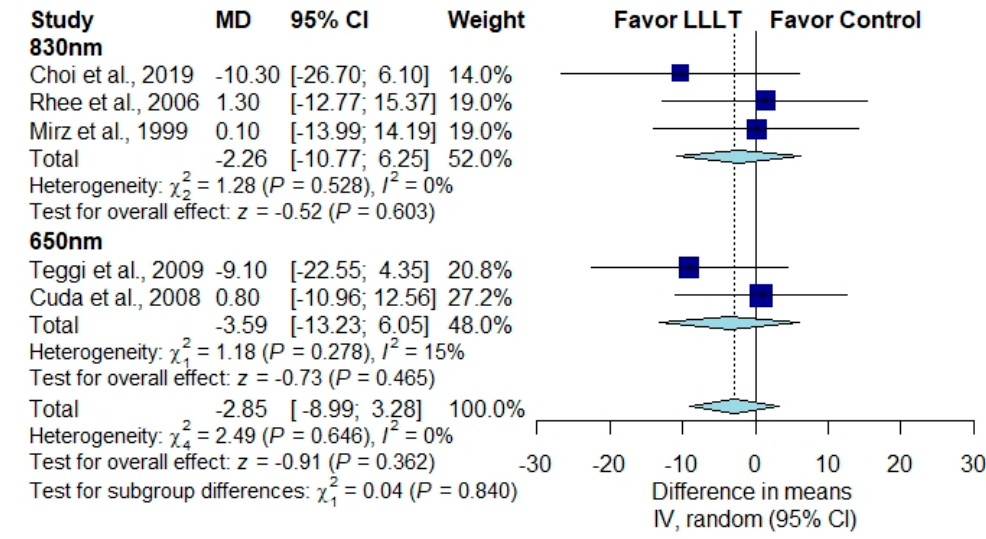
Figure 8. Subgroup analysis according to wavelength setting [1,28–31].